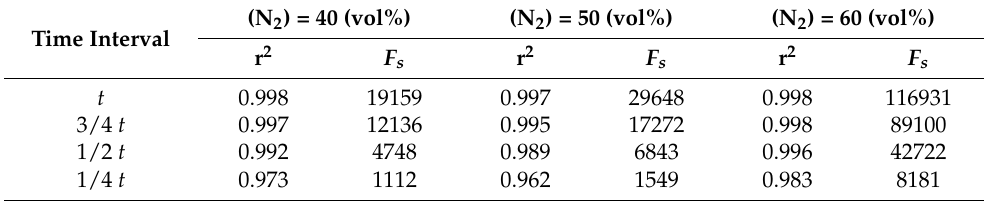
Table 2. The determination coefficients (r 2 ) and the value of the statistical factors ( F s ).